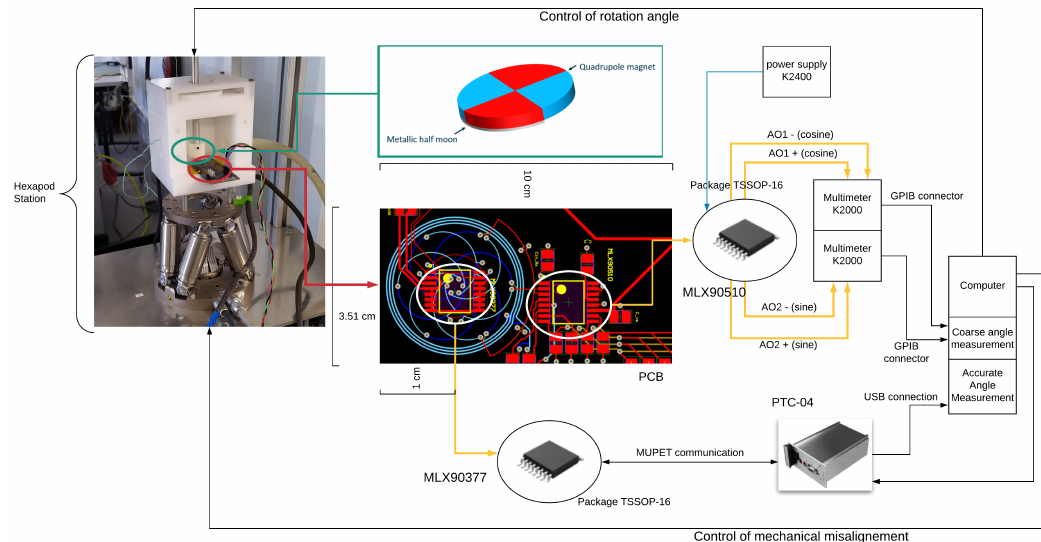
Figure 6. Block diagram of the hybrid sensor embedded in the measurement